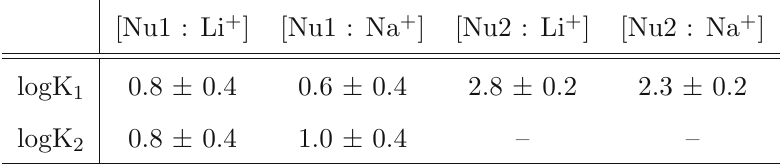
) and 1:2 (log K ) 1 2